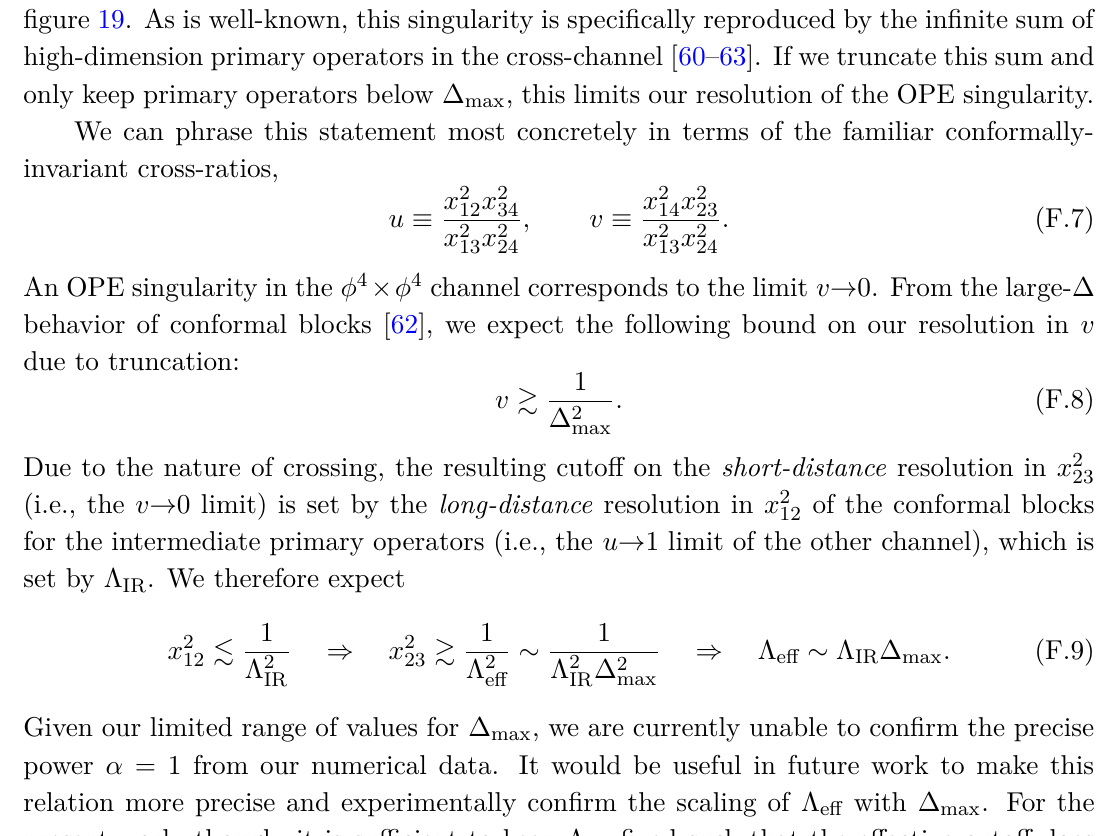
sets an effective UV max